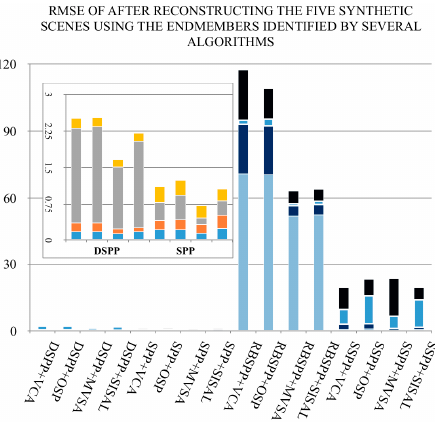
Figure 14. RMSE between the five reconstructed images and the original images.